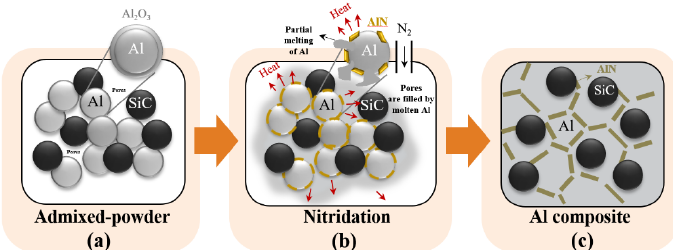
Figure 1. A schematic diagram of the nitridation-induced self-formed aluminum composite (NISFAC) process: (a) admixed powder, (b) nitridation, and (c) Al composite.